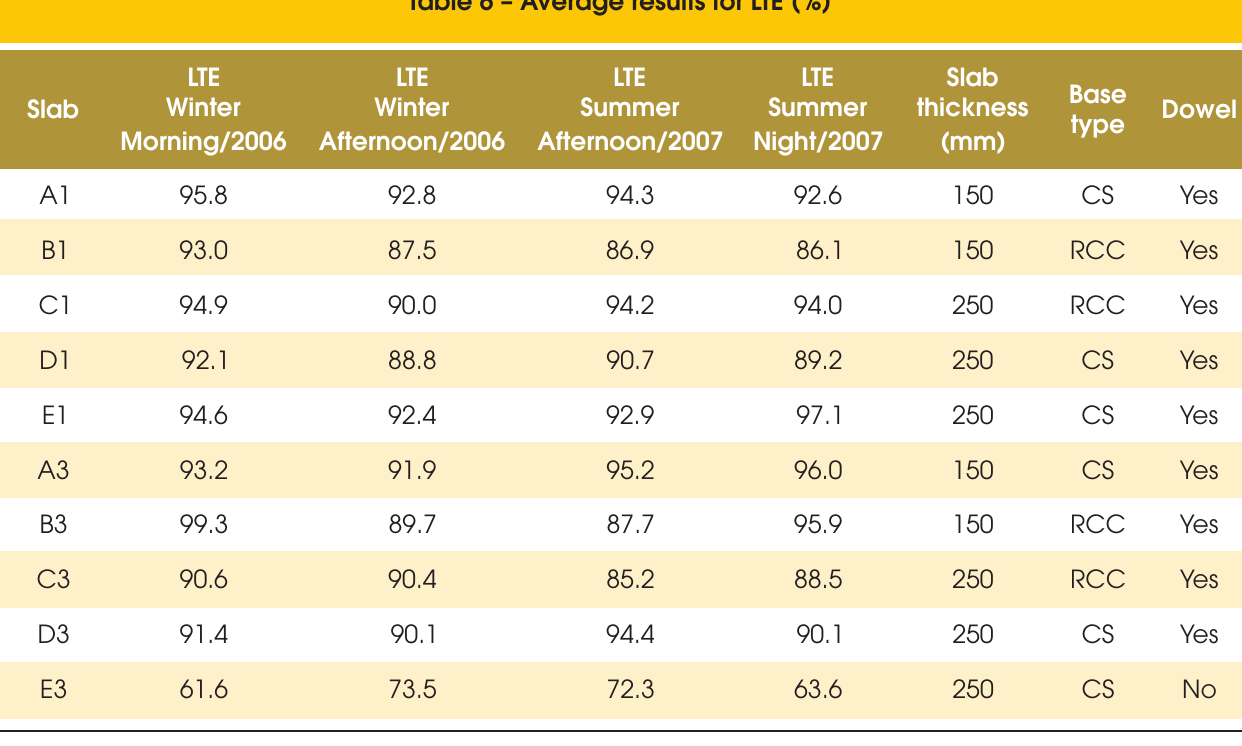
Table 6 – Average results for LTE (%)